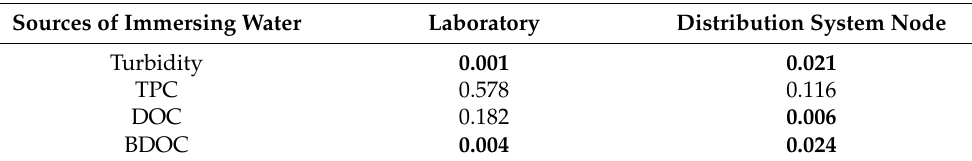
Table 2. Effects of pipe materials on water quality in water from different sources using Kruskal – Wallis ANOVA. Factors with a p -value smaller than 0.05 are highlighted in bold.